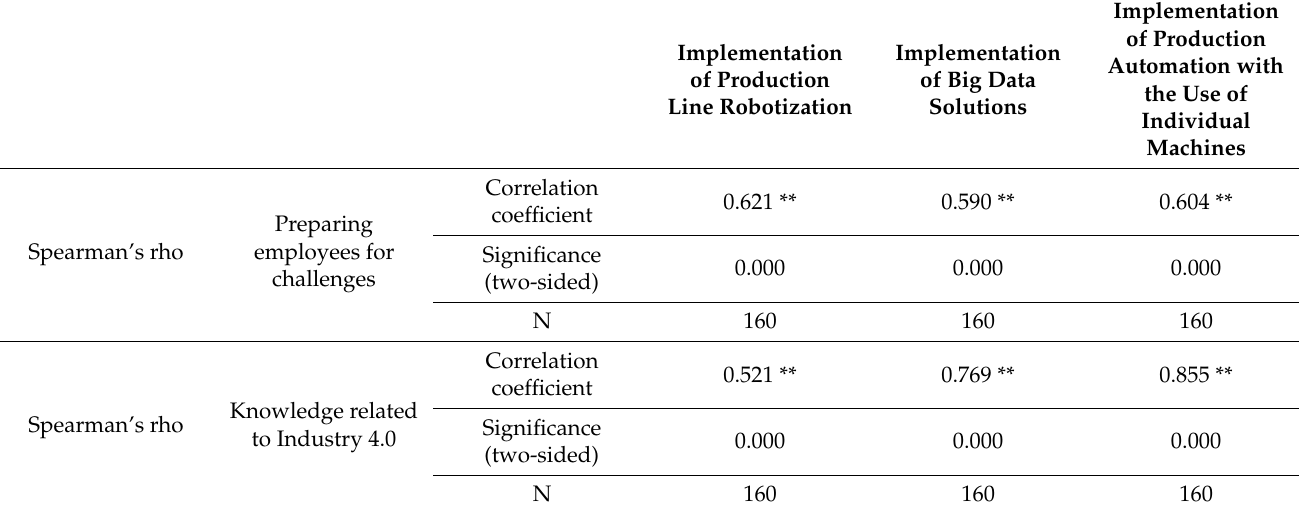
Table 3. Correlation Between the Level of Knowledge Related to Industry 4.0 and the Implementation of Industry 4.0 Technology—Results for Poland and Malaysia.